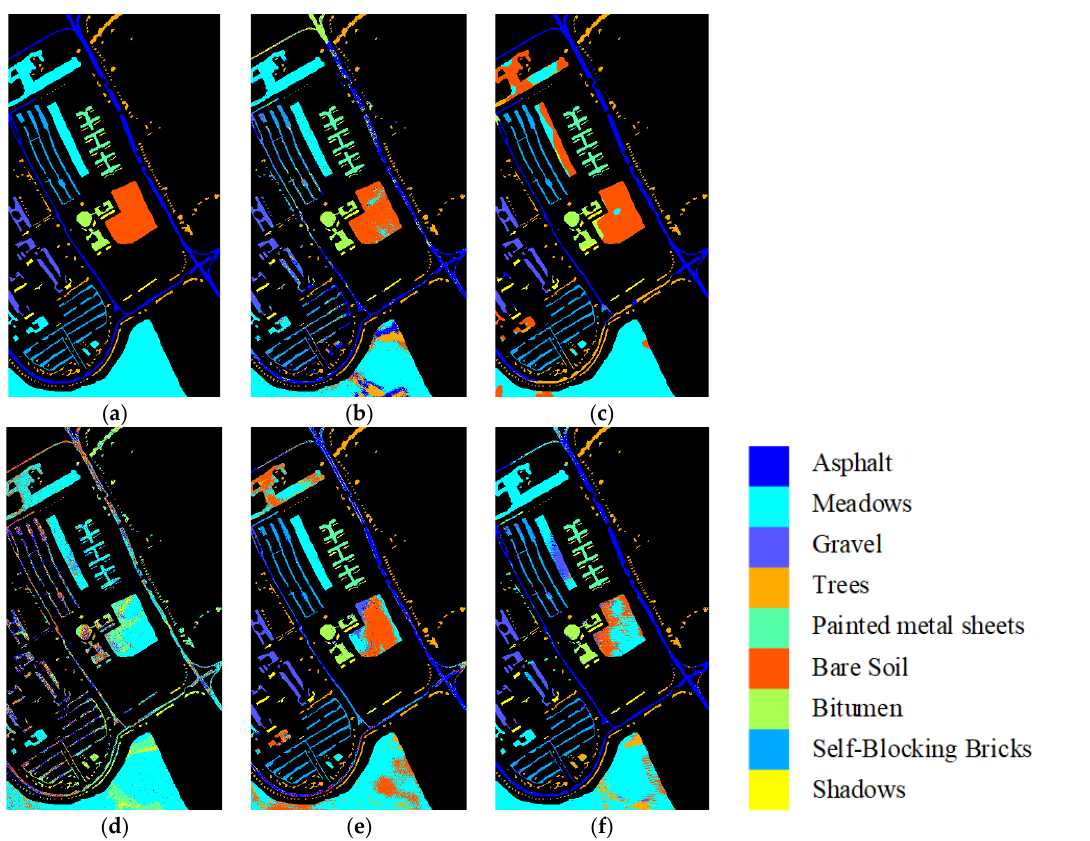
Figure 15. Classification maps of different model (training sample = 10) on the IP dataset. ( a ) Ground-truth map. ( b ) HybridSN. ( c ) MAPC. ( d ) MFFN. ( e ) DC-CNN. ( f ) DSEN.